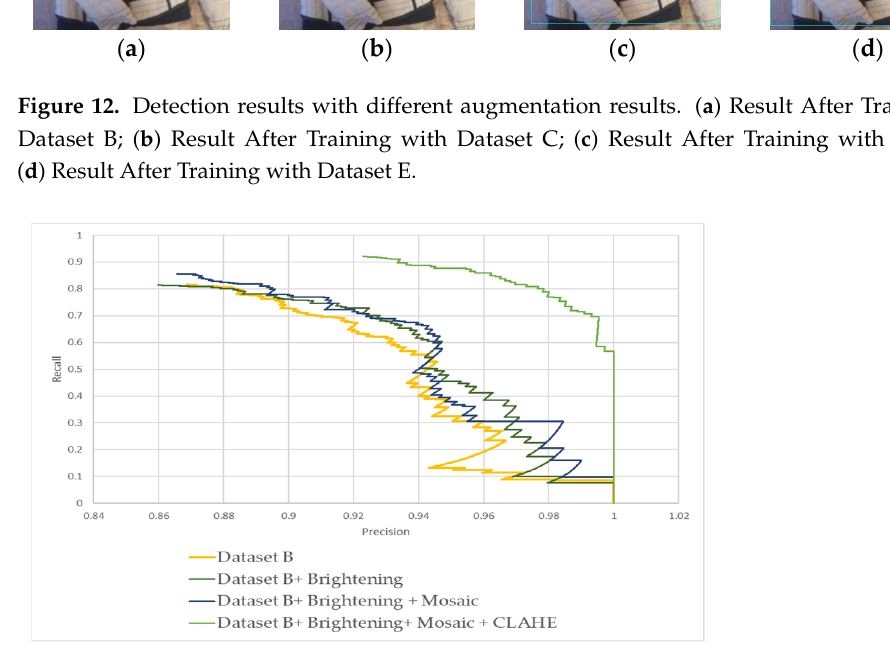
Figure 13. Precision-Recall Curve for different image augmentation.